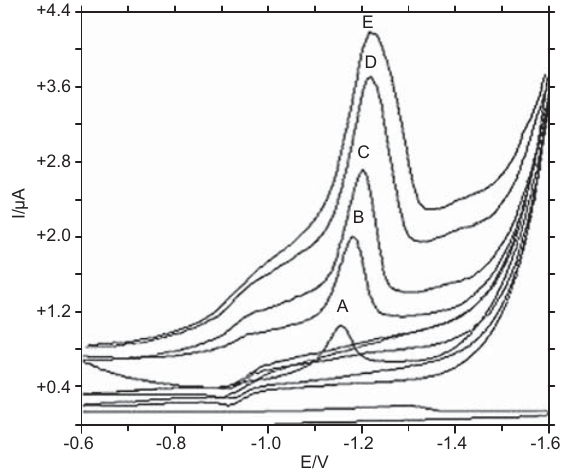
Figure 2 Cyclic voltammogram of EZE on HMDE. Supporting